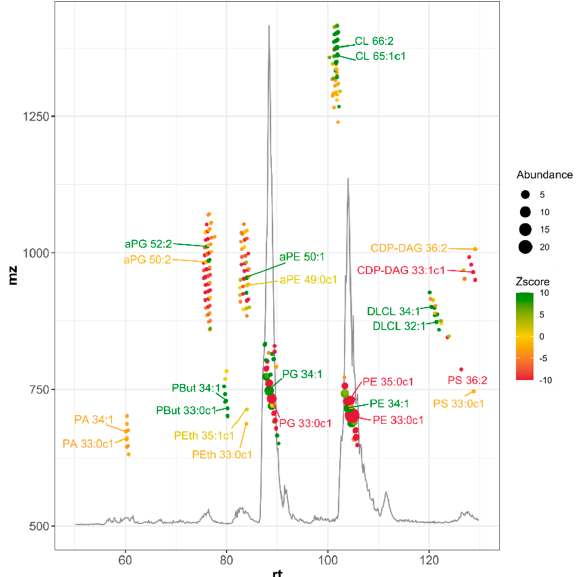
Figure 2. Base peak chromatogram of HILIC-based LC-MS analysis of wild type E. coli lipid extract. Lipid species are depicted, and color coded according to the Z-score of culturing in the presence of 0.5% n -butanol (green corresponding to higher abundance at n -butanol exposure). Dot size corresponds to abundance in WT n -butanol-free cultures. The two most abundant species of each lipid class are labeled. All lipid ions corresponded to deprotonated molecules. Examples of structures for each class of lipid ions are given in Supplementary Figure